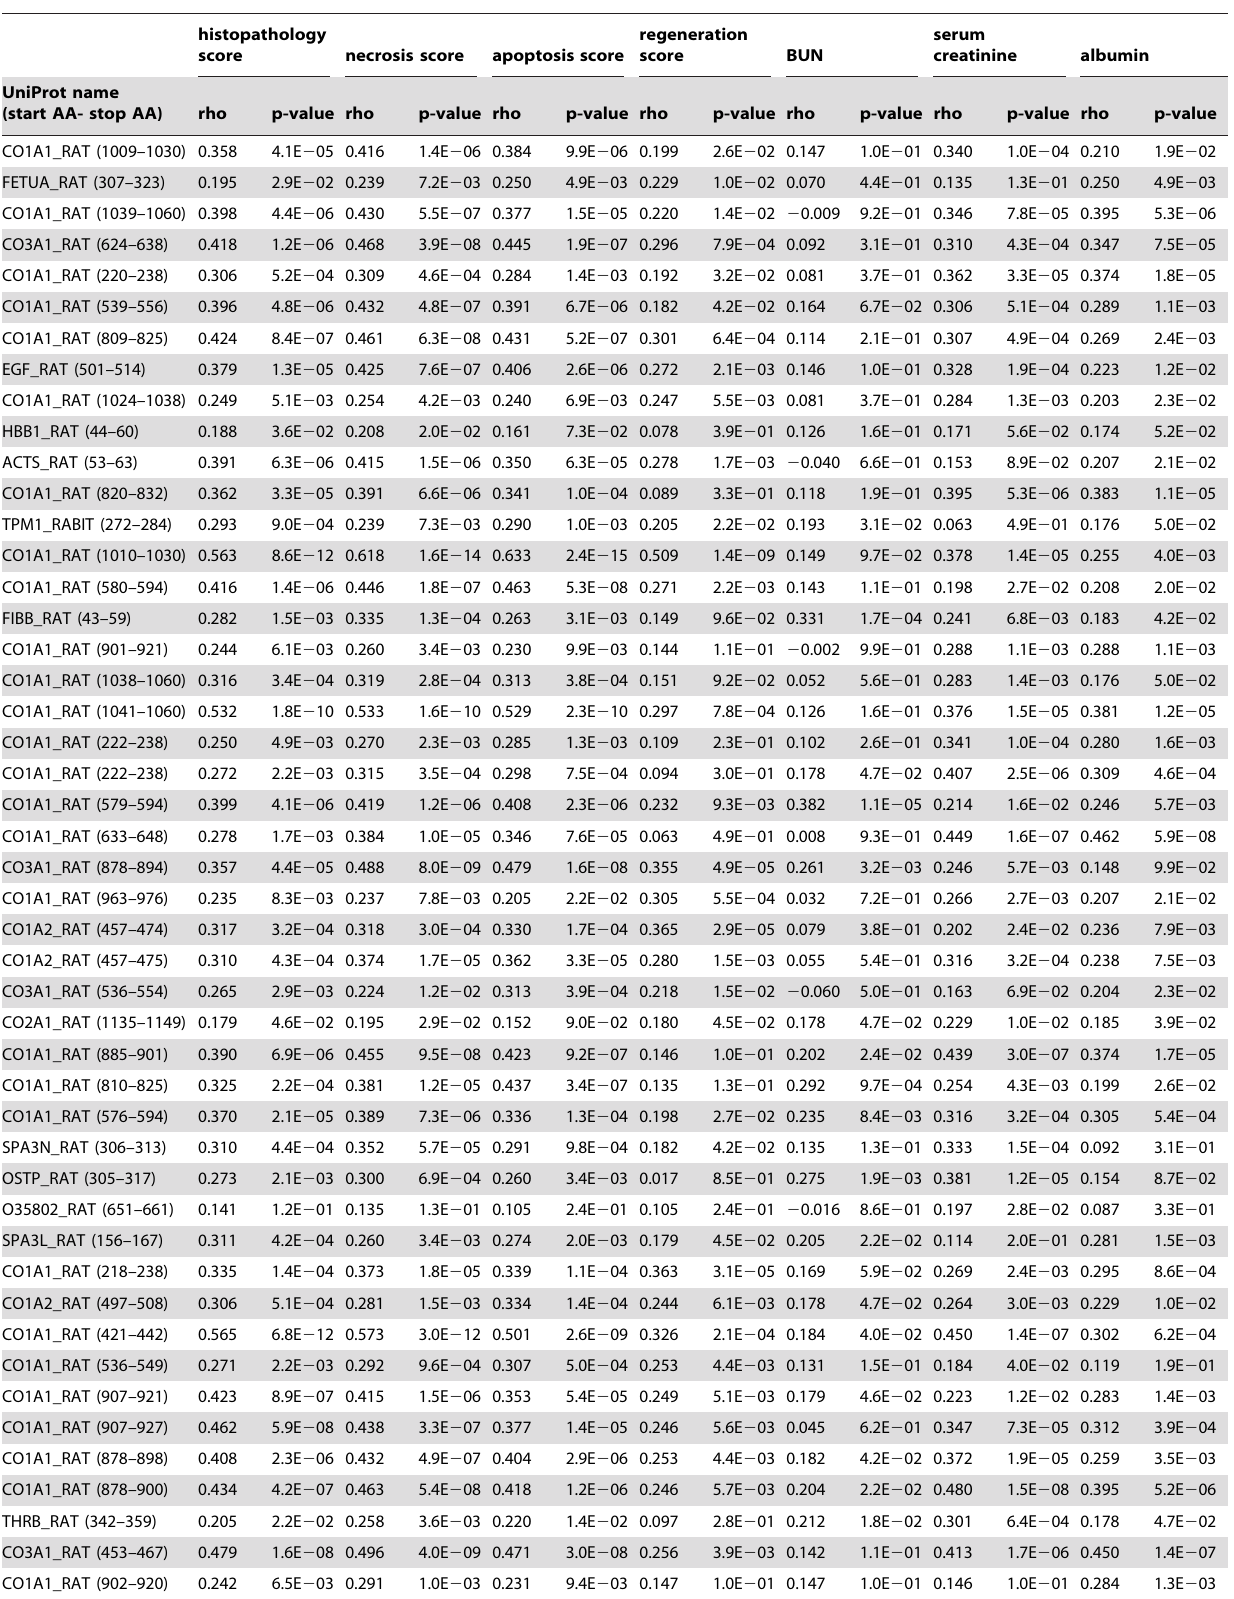
Table 3. Correlation of urinary peptide biomarkers, as well as the biomarker models with histopathology changes and other investigated kidney injury